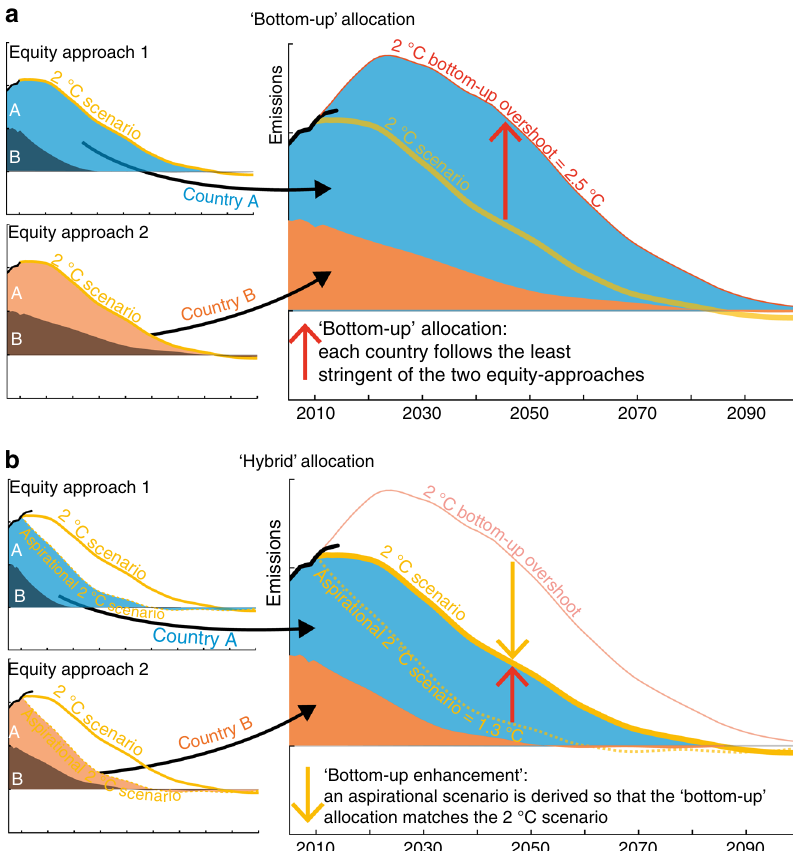
Fig. 1 Schematic description of the bottom-up and hybrid allocations of global emissions scenarios. a Under the bottom-up allocation, each country adopts the least-stringent equity approach. As a result of this self-interested allocation, the targeted 2 °C scenario is overshot. b An aspirational scenario is created so that its overshoot under the bottom-up allocation matches the originally targeted 2 °C scenario. Each country individually adopts the least-stringent equity approach of the aspirational scenario in order to collectively achieve the originally targeted 2 °C